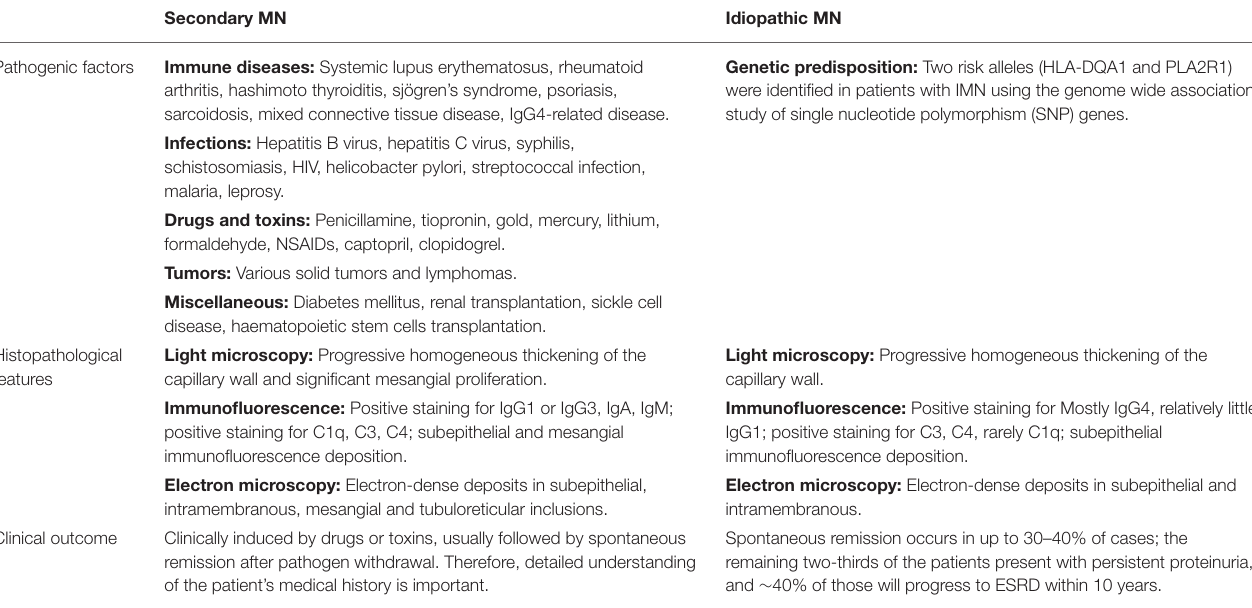
TABLE 1 | Pathogenic factors, histopathological features, and clinical outcomes of secondary and idiopathic membranous nephropathy. Secondary MN Idiopathic MN Pathogenic